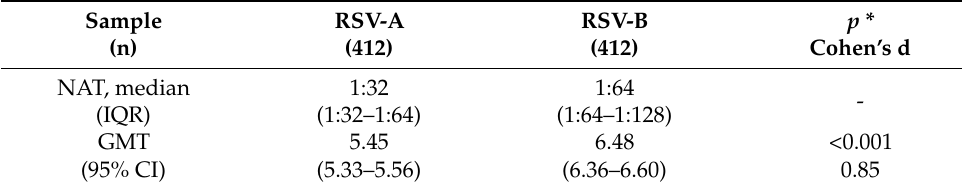
Table 2. NATs against RSV-A and RSV-B in maternal blood.